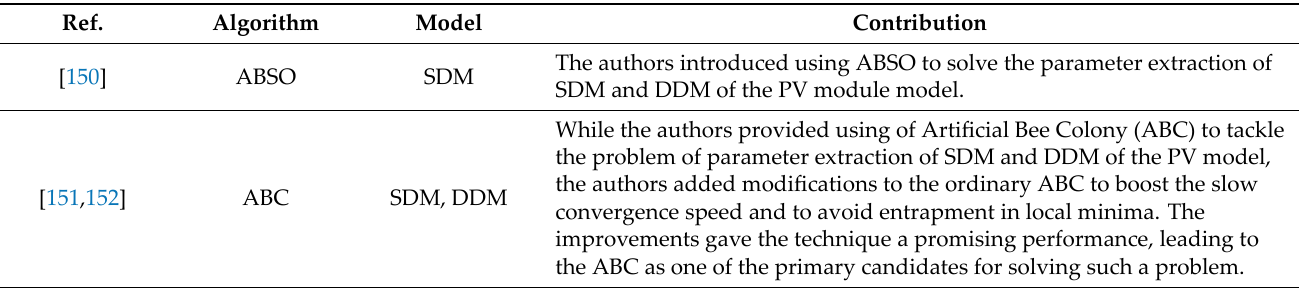
Table 9. Soft computing algorithms—bio‑inspired metaheuristic algorithms.